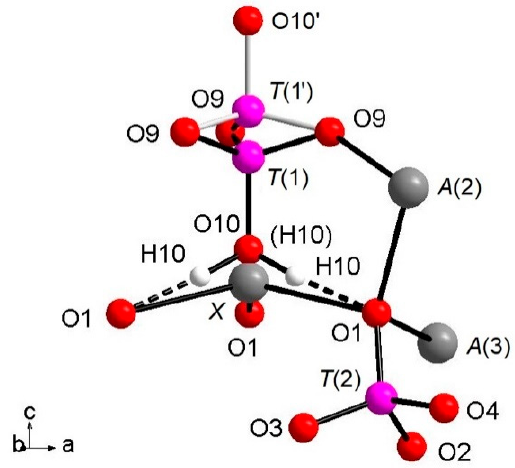
Figure 1. View of the ( T (1)O 3 OH) group split along c axis; details of O10-H10…O. 1 hydrogen bond and coordination of O1 are also added.